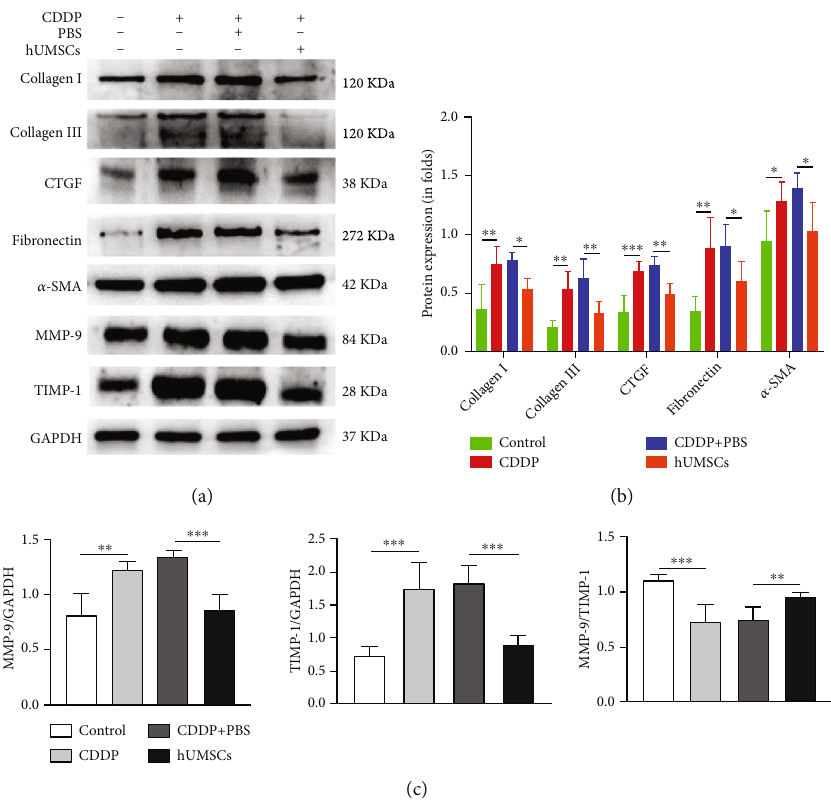
Figure 4: Western blot analyses of uterine tissue fi brosis-related, MMP-9, and TIMP-1 proteins. (a) Uterine expressions of Collagen I, Collagen III, CTGF, Fibronectin, α -SMA, MMP-9, and TIMP-1 in each group. A representative blot from one of the three independent experiments performed is shown. GAPDH was used as the loading control. (b) Expressions of Collagen I, Collagen III, CTGF, Fibronectin, and α -SMA protein as quantitated using ImageJ software. (c) Levels of MMP-9, TIMP-1, and the MMP-9/TIMP-1 ratio in each group. Data are presented as the means ± SDs . ∗ P < 0 : 05, ∗∗ P < 0 : 01, and ∗∗∗ P < 0 : 001 . CDDP: cisplatin; Collagen I: Collagen Type I; Collagen III: Collagen Type III; CTGF: connective tissue growth factor; α -SMA: alpha smooth muscle actin; MMP-9: matrix metalloprotein 9; TIMP-1: tissue inhibitor of metalloproteinase-1; GAPDH: glyceraldehyde-3-phosphate